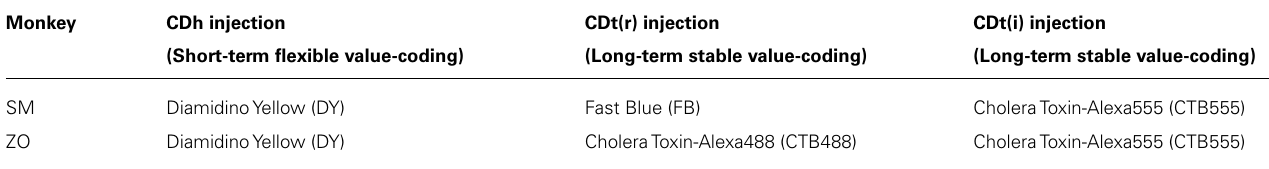
FIGURE 2 |Value-coding map of CD. (A) Average responses to the flexibly valued objects of neurons in CDh ( n = 71) and CDt ( n = 54). Neuronal responses were averaged for the neurons’ preferred values (magenta) and non-preferred values (black) using a cross-validation method. The green line indicates the mean of the differences between the preferred and non-preferred responses, and the black line behind the green line indicates the standard error of the differences (mean ± SE). (B) Average responses to the stably valued objects of neurons in CDh ( n = 32) and CDt ( n = 59). Same format as in (A) . Data in (A,B) were Table 1 | Retrograde tracers injected into CDh or